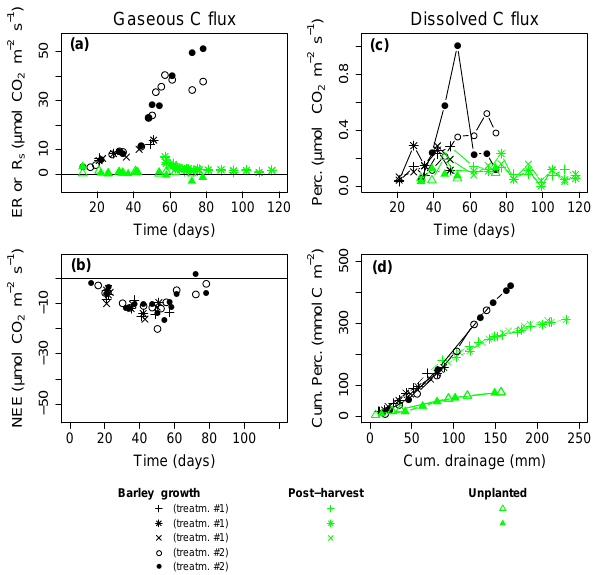
Figure 3. Gaseous and dissolved CO 2 fluxes from mesocosms. (a) : ecosystem respiration (ER) from barley mesocosms during growth (black) and soil respiration ( R s ) from barley mesocosms af- ter harvest and unplanted mesocosms (green). (b) : net ecosystem exchange (NEE) from mesocosms with barley. (c) : dissolved inor- ganic carbon (DIC) percolation flux recalculated into gaseous efflux unit. (d) : cumulative DIC percolation flux as a function cumulative drainage.